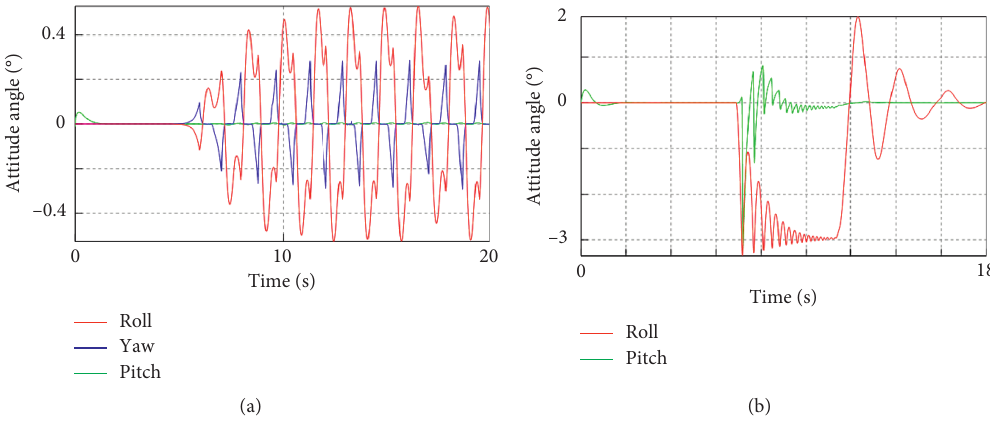
Figure 23: Change of the attitude angle after optimization under different driving conditions: (a) straight line and (b) bend